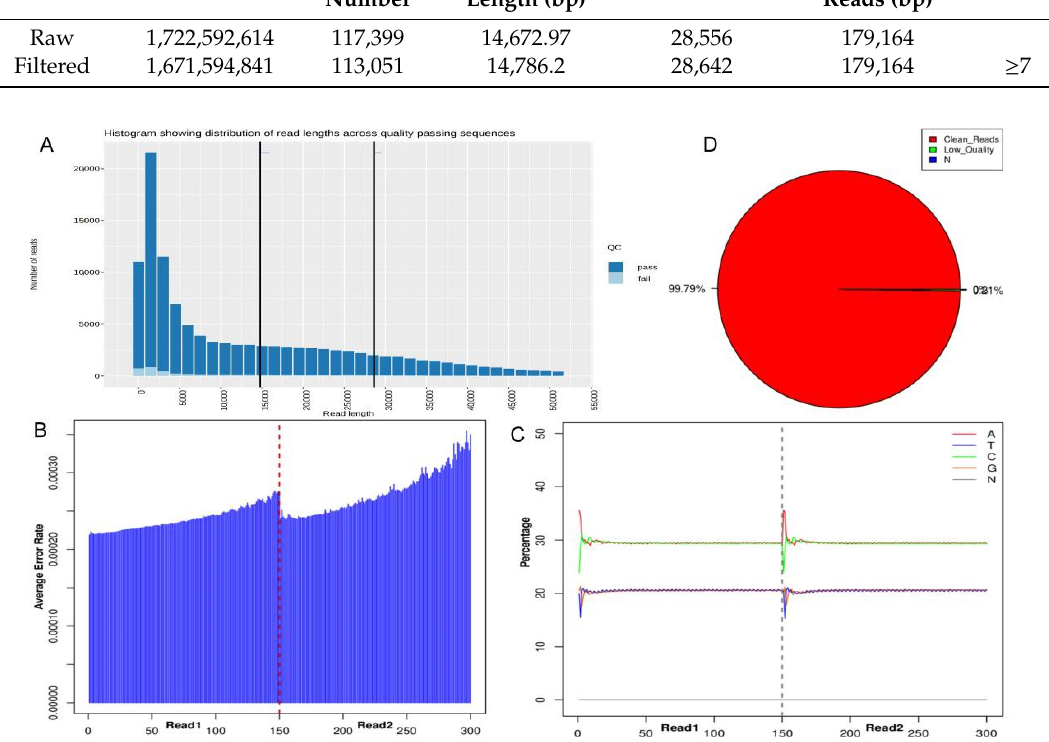
Figure 1. Sequencing quality control information of Lactobacillus sakei (L. sakei). ( A ) Histogram of reading lengths and number distribution of sequencing; ( B ) Base sequencing error rate distribution map; ( C ) Bases (ATGC) content distribution map; ( D ) Original data composition